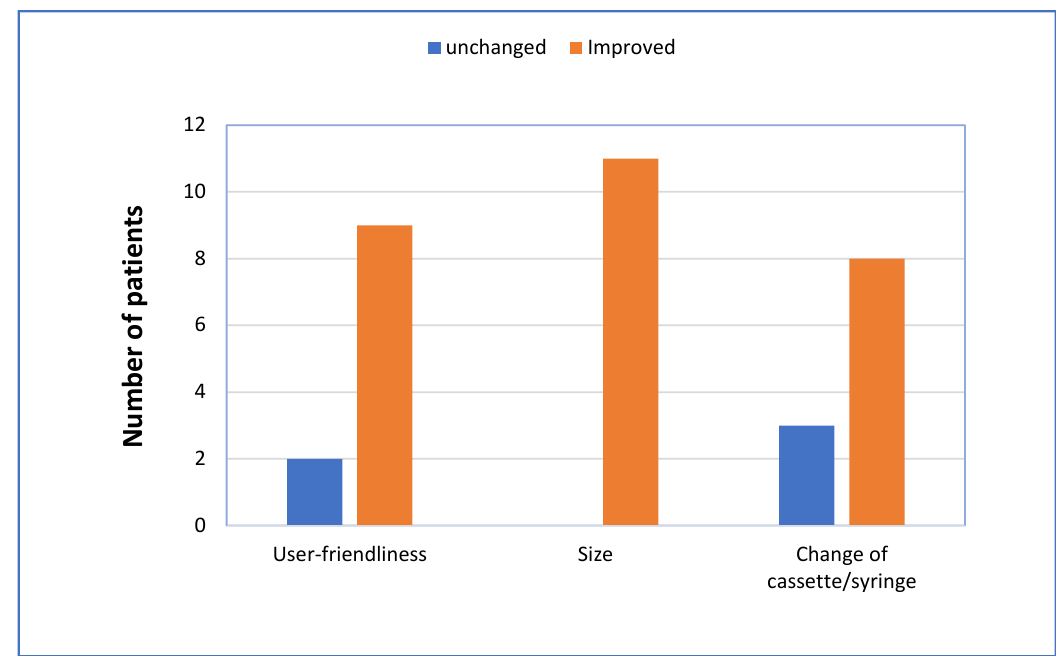
Figure 3. Comparison of pump characteristics by patients who switched from LCIG to LECIG. ( n = 11).